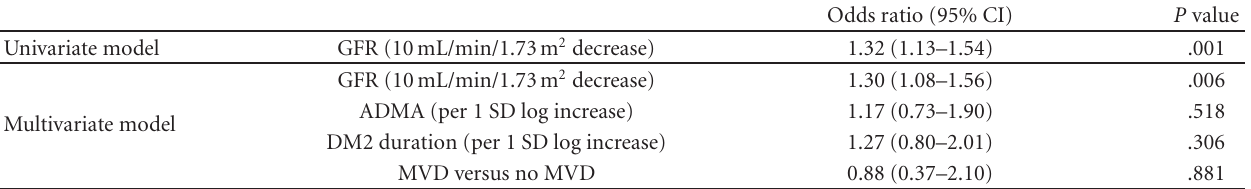
Table 5: Univariate and multivariate logistic regression analysis including diabetic retinopathy as dependent variable and glomerular filtra- tion rate (GFR) and possible confounders as independent